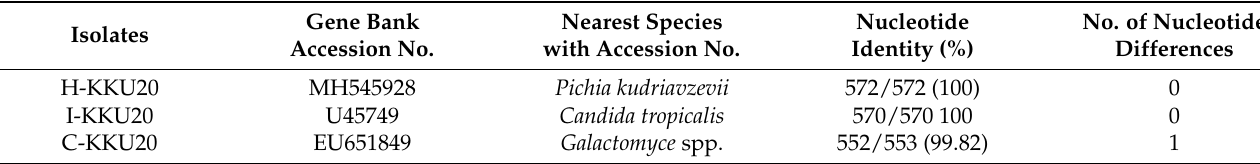
Table 2. Identification of isolated yeast from rumen